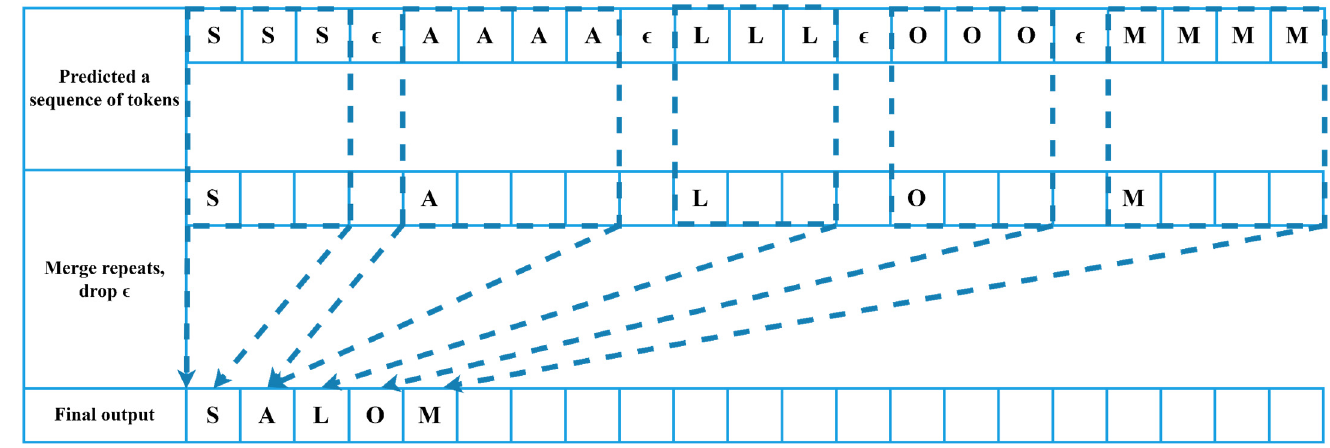
Figure 4. CTC networks were employed in this research for speech recognition [40]. CTC more reliably translates the expected sequence of tokens to valid words. The delay and repeated tokens in the anticipated sequence “sss aaaa lll ooo mmmm” are removed, leaving the final output as “salom” with the greatest probability.